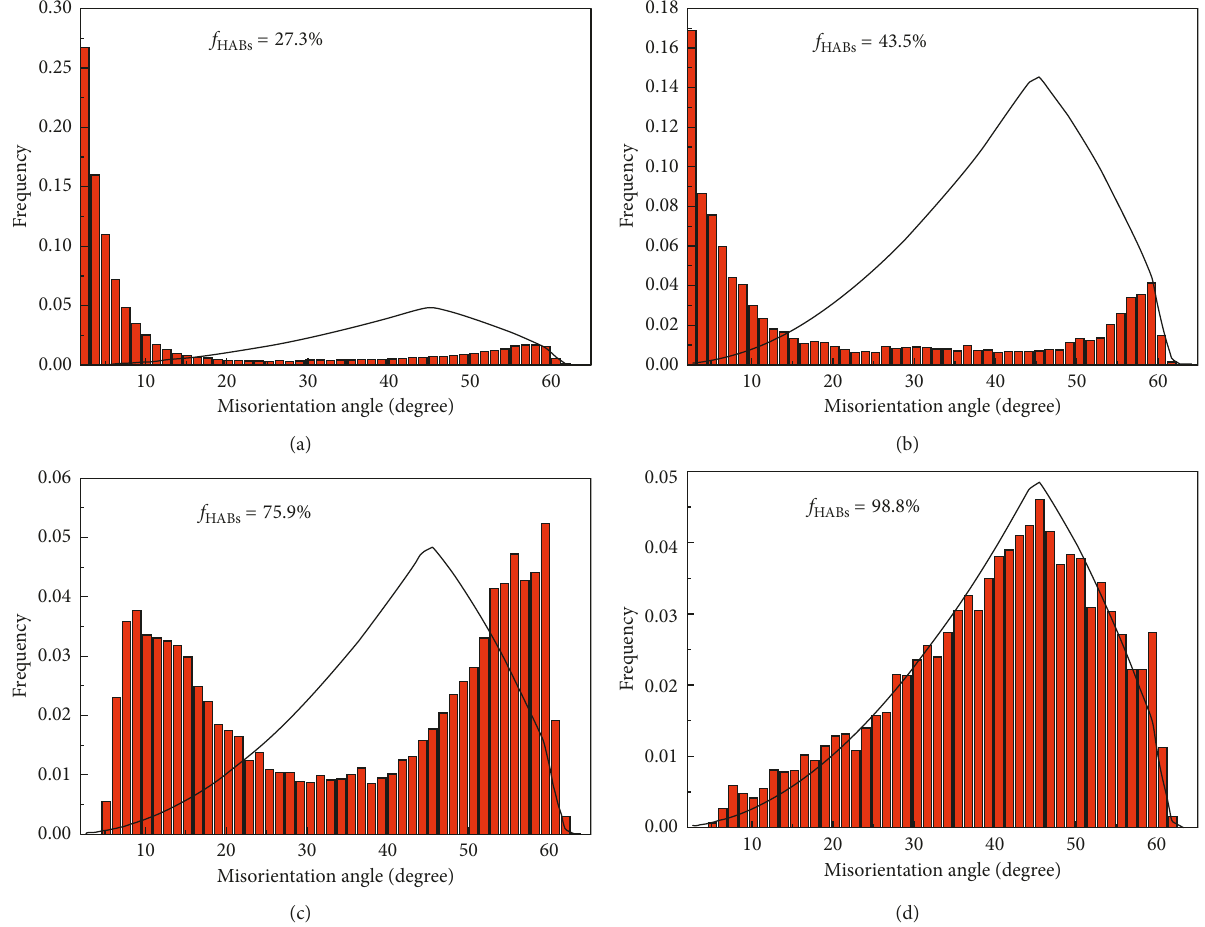
2 1 after interrupting the 10 s × · − −